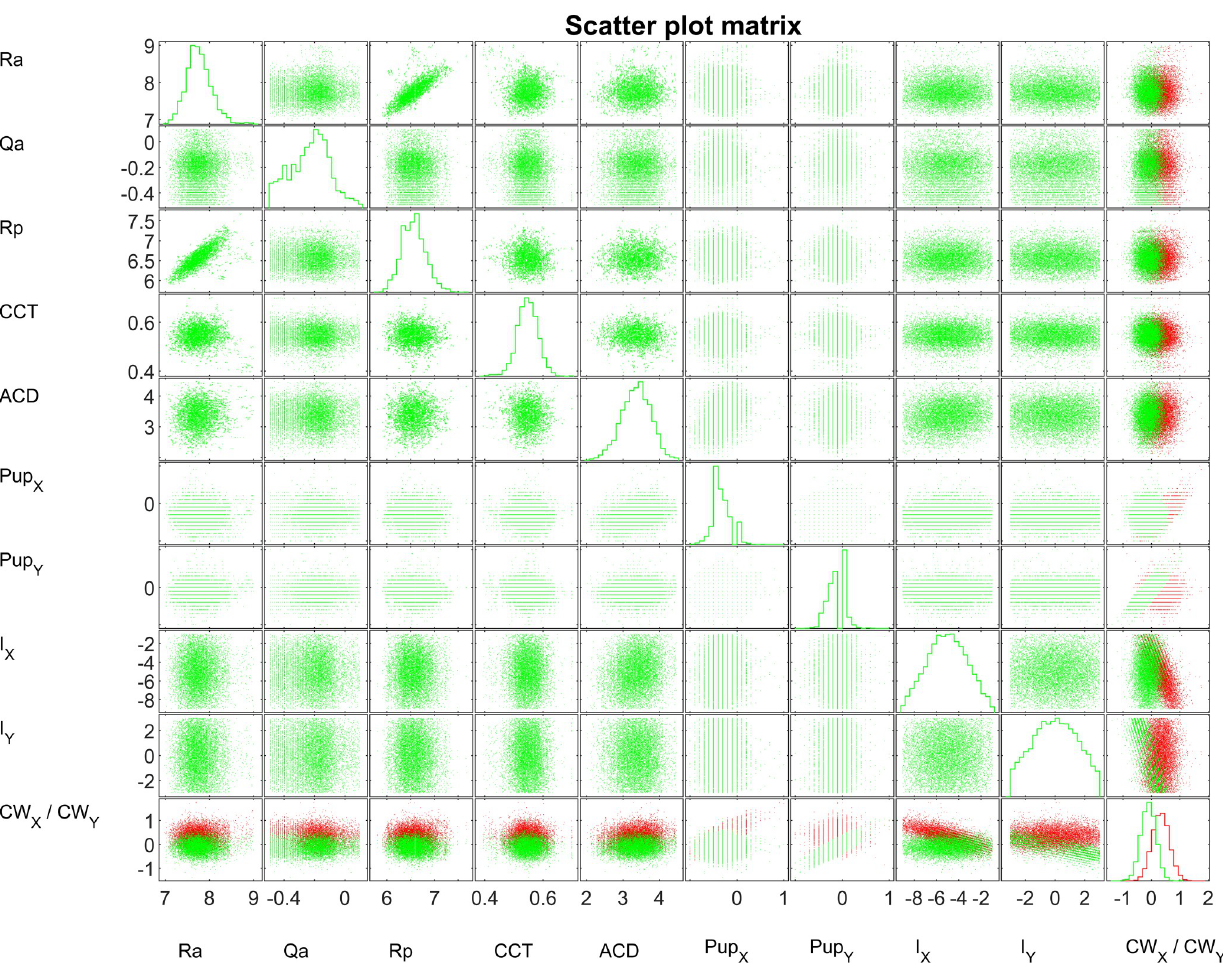
Fig 2. Matrix of grouped scatterplots for the relevant input parameters of the multivariable linear prediction model and the components of the CW chord (CW X in red, CW Y in green). The respective histograms are plotted on the diagonal of the matrix. The relevant effect sizes for CW X are identified with a stepwise fit algorithm to anterior and posterior corneal curvature Ra and Rp, asphericity of corneal front surface Qa, central corneal thickness CCT, anterior chamber depth ACD, position of the pupil centre Pup X and Pup Y , and incident ray angle I X . The relevant effect sizes for CW Y are identified to anterior and posterior corneal curvature Ra and Rp, position of the pupil centre Pup Y , and incident ray angle I Y . The model is based on a dataset with N = 8959 eye